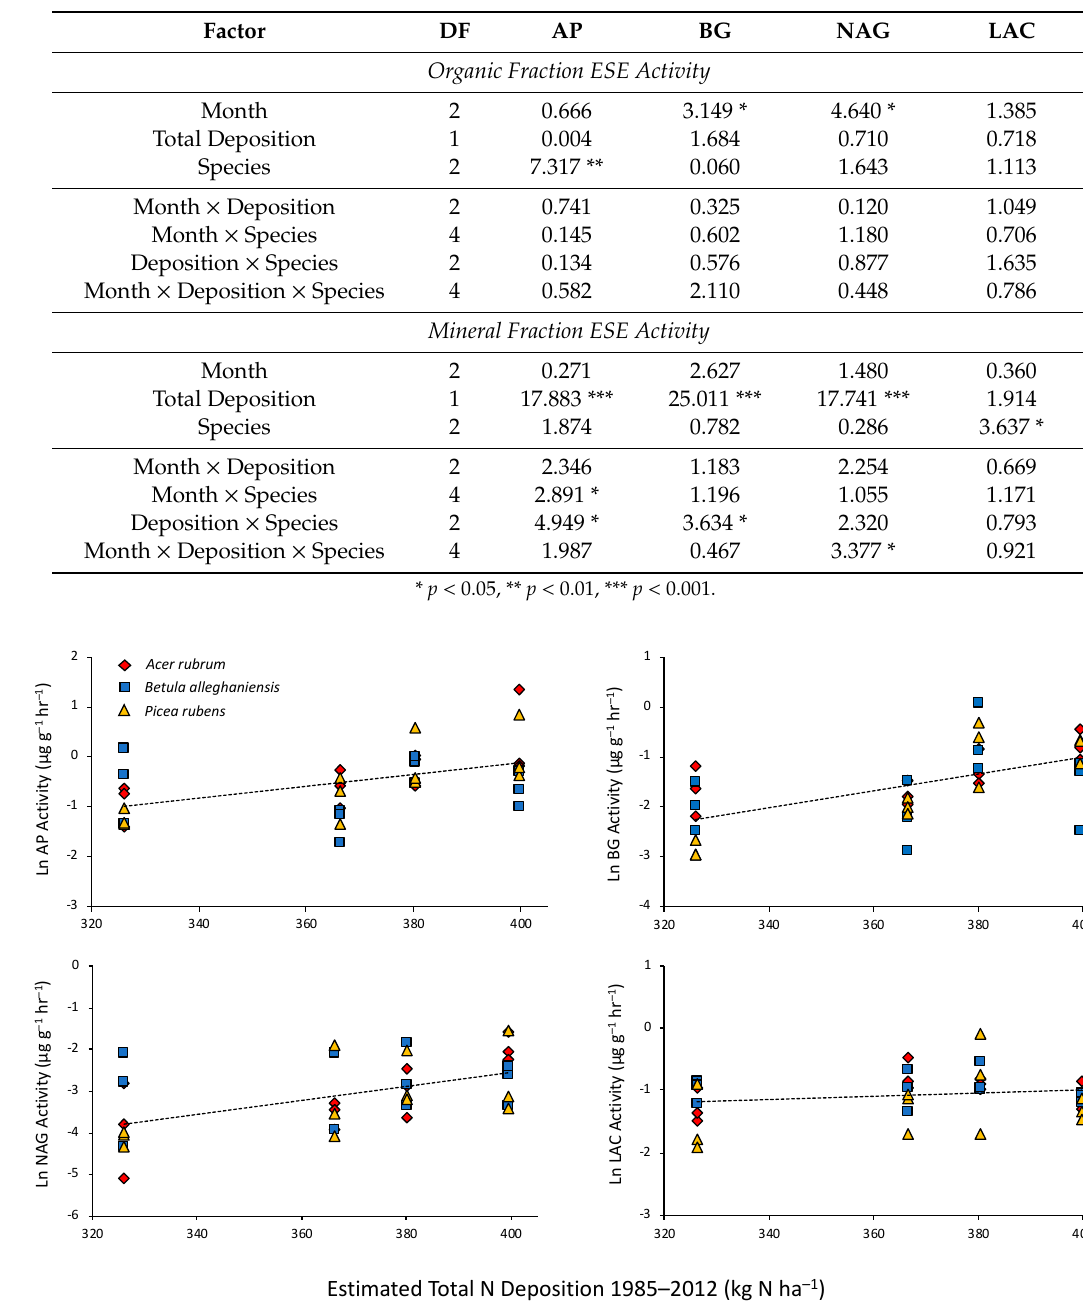
Figure 3. Activity of AP, BG, NAG, and LAC in mineral soil fraction as functions of estimated total N deposition into high elevation spruce forests. Each symbol represents the activity in samples beneath three replicate trees of each species. Regression lines are best fits across all species. Slopes ± SE [ln(µg g –1 h –1 ) (kg N ha –1 ) –1 ] for the regressions are: AP, 0.0115 ± 0.0027 ( p < 0.001), BG, 0.0173 ± 0.0036 ( p < 0.001), and NAG, 0.0161 ± 0.0041 ( p < 0.001), LAC, 0.0026 ± 0.0018 ( p = 0.161).